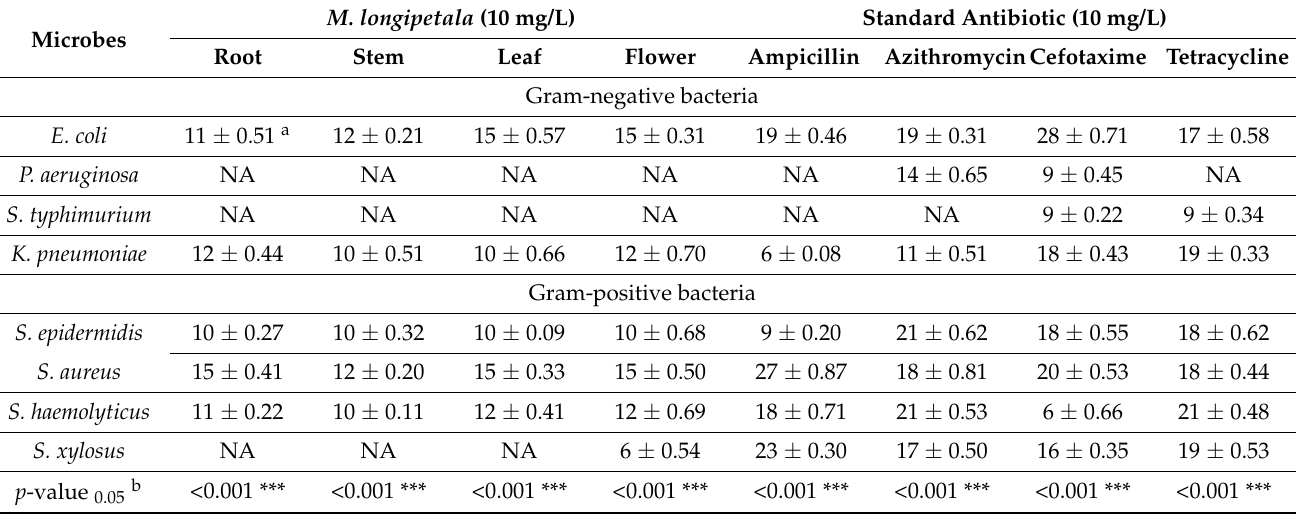
Table 2. The antibacterial activity of the methanol extract (10 mg/L) of different parts of M. longipetala and antibiotics against various bacterial